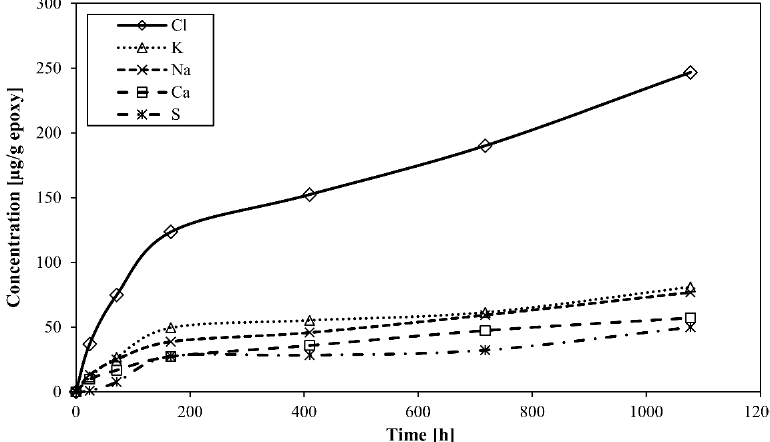
Figure 6. Ca, Cl, K, Na and S release from neat resin during hygrothermal aging at 60 °C.